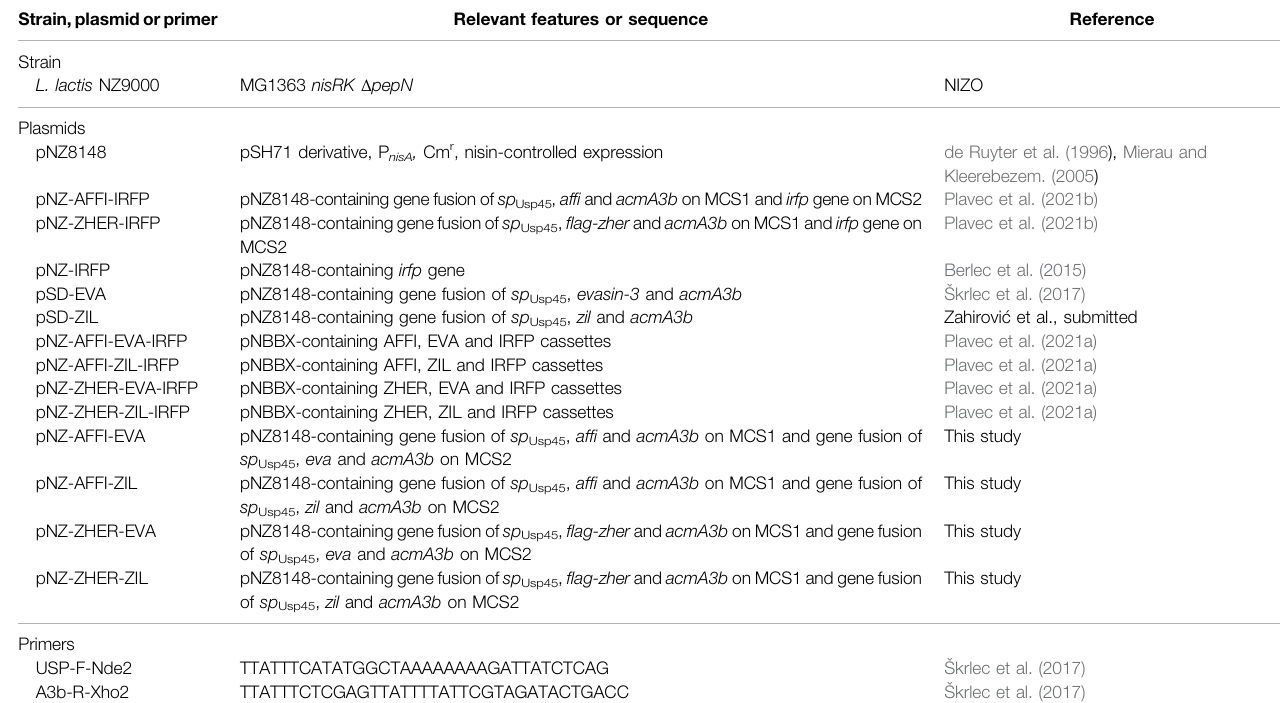
TABLE 1 | The strains, plasmids and primers used in this study. Strain,plasmidorprimer Relevant features or